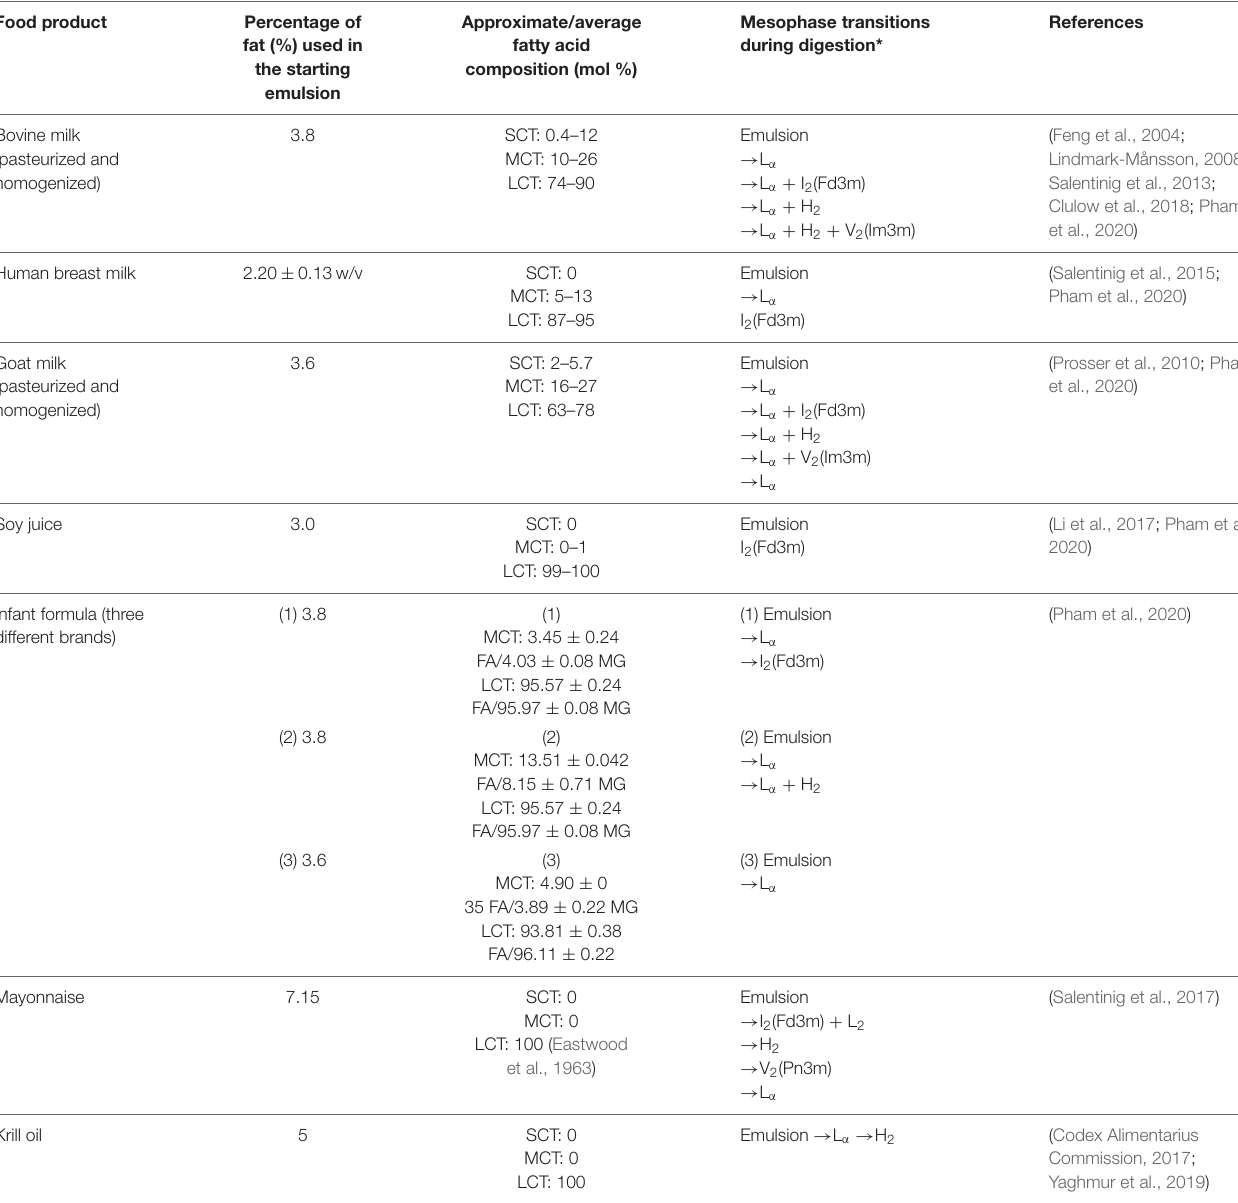
TABLE 1 | Summary of food type, the approximate lipid composition (SCT = short chain triglyceride, MCT = medium chain triglyceride, LCT = long chain triglyceride, FA = fatty acid, MG = monoglyceride), and the corresponding mesophase transitions that occur during digestion. Food